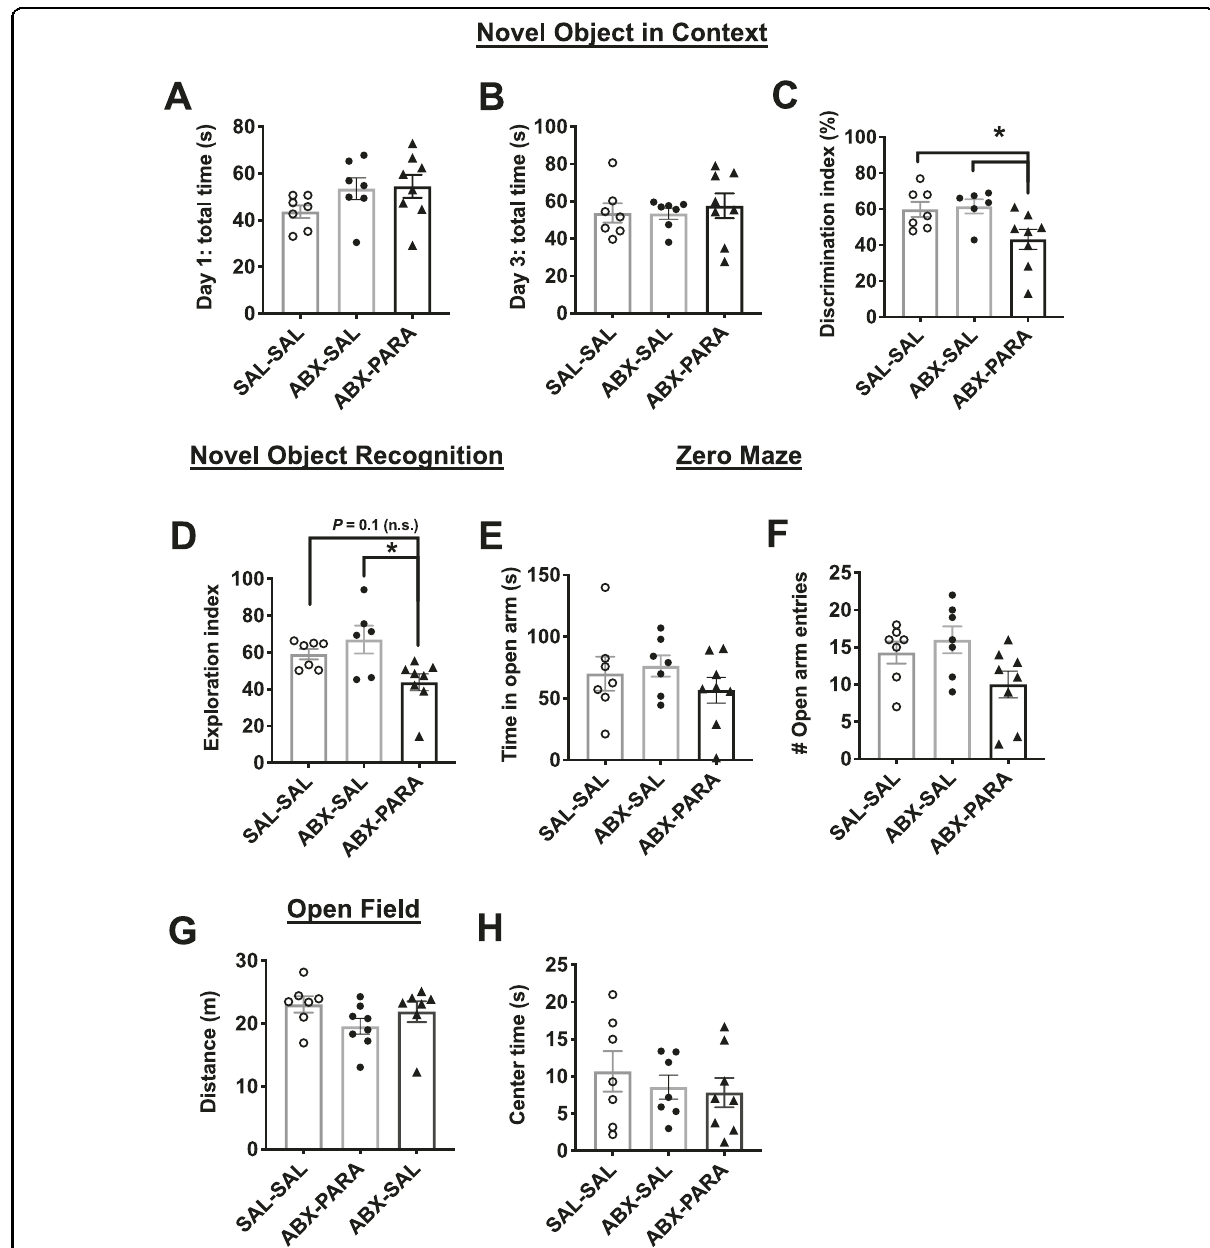
Fig. 4 Early life enrichment with Parabacteroides negatively impacts neurocognitive function. A , B Early life enrichment with a 1:1 ratio of P. johnsonii and P. distasonis had no effect on total exploration time in the Novel Object in Context (NOIC) task. C Discrimination index was signi fi cantly reduced by enrichment with P. johnsonii and P. distasonis , indicating impaired hippocampal function ( n = 7,8; F (2, 19) = 4.92; P < 0.05, one- way ANOVA with Tukey ’ s multiple comparison test). D There was a signi fi cant reduction in the exploration index in the Novel Object Recognition (NOR task), indicating impaired perirhinal cortex function ( n = 7,8; F (2, 19) = 3.61; P < 0.05, one-way ANOVA with Tukey ’ s multiple comparison test). E , F There were no differences in time spent or a number of entries into the open arm by animals with P. johnsonii and P. distasonis enrichment in the Zero Maze task for anxiety-like behavior ( n = 7,8; one-way ANOVA). G , H There were no differences in distance traveled or time spent in the center arena in the Open Field task ( n = 7,8; one-way ANOVA). SAL – SAL saline – saline control, ABX-SAL antibiotics-saline control, ABX-PARA antibiotics- P. johnsonii and P. distasonis enriched, PN post-natal day; data shown as mean ± SEM; * P <